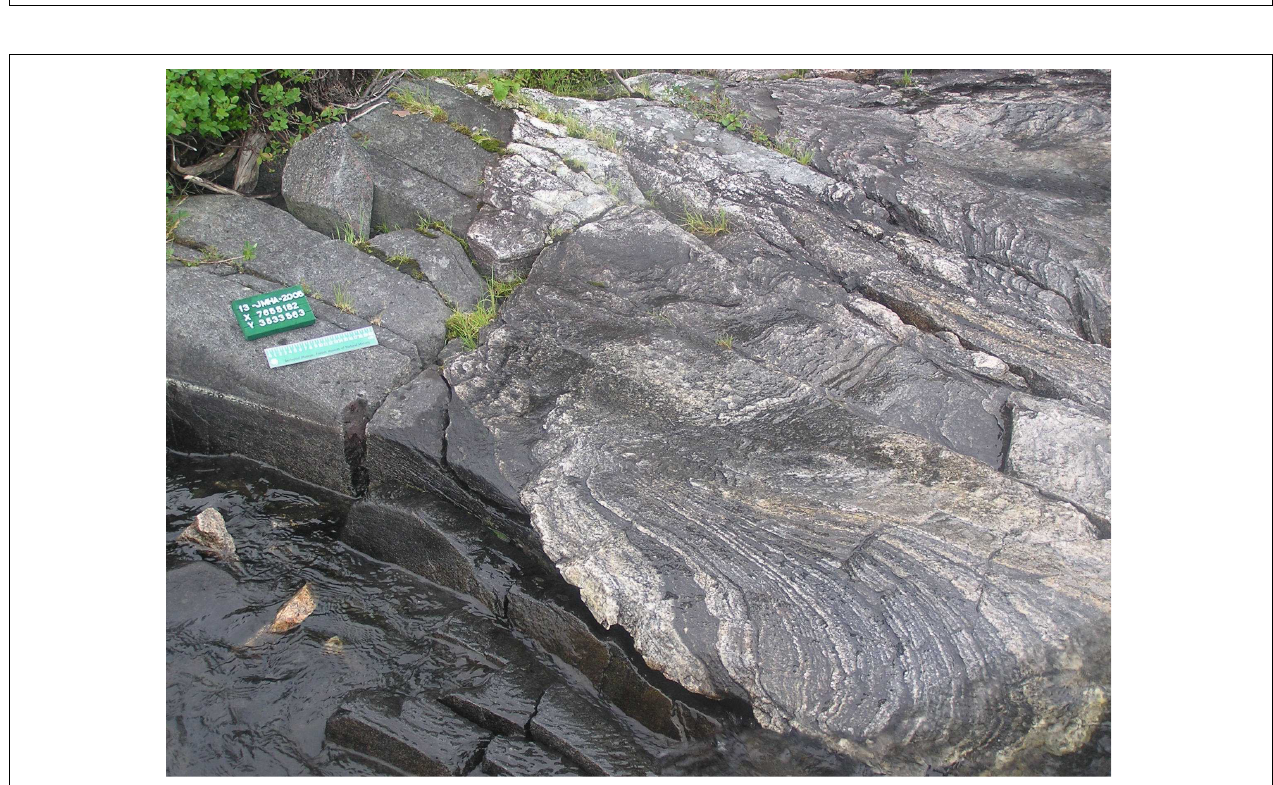
FIGURE 10 | Weathering enhances the appearance of a flow band wrapping around the amphibolite raft. Lake Inari, Kola Province, NE Finland. Length of scale 20 cm. Photo: Pekka Kivimäki.